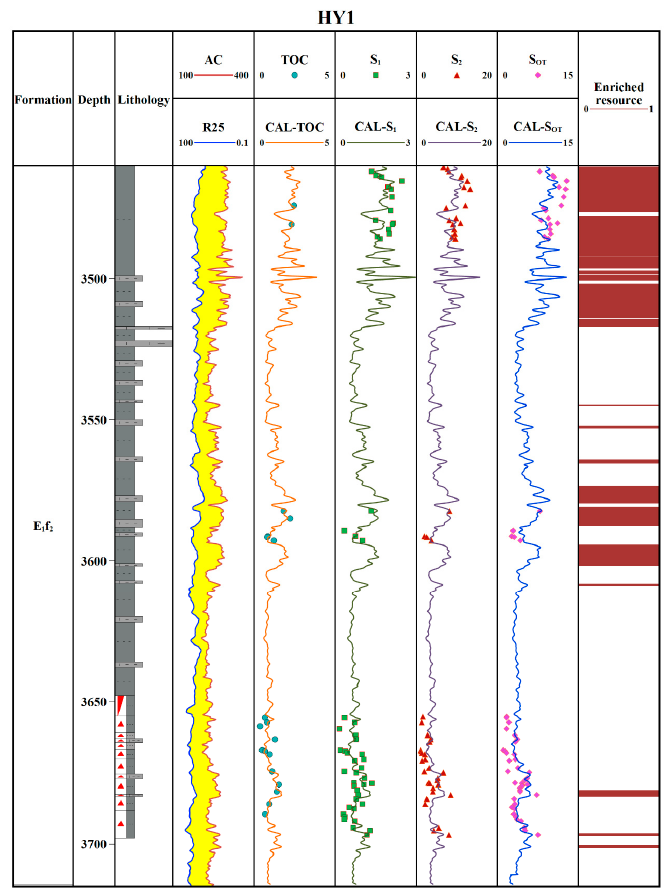
Figure 9. Results calculated using the Δ log R method of Well HY1. (The red triangles in Lithologic series mean oil immersion).